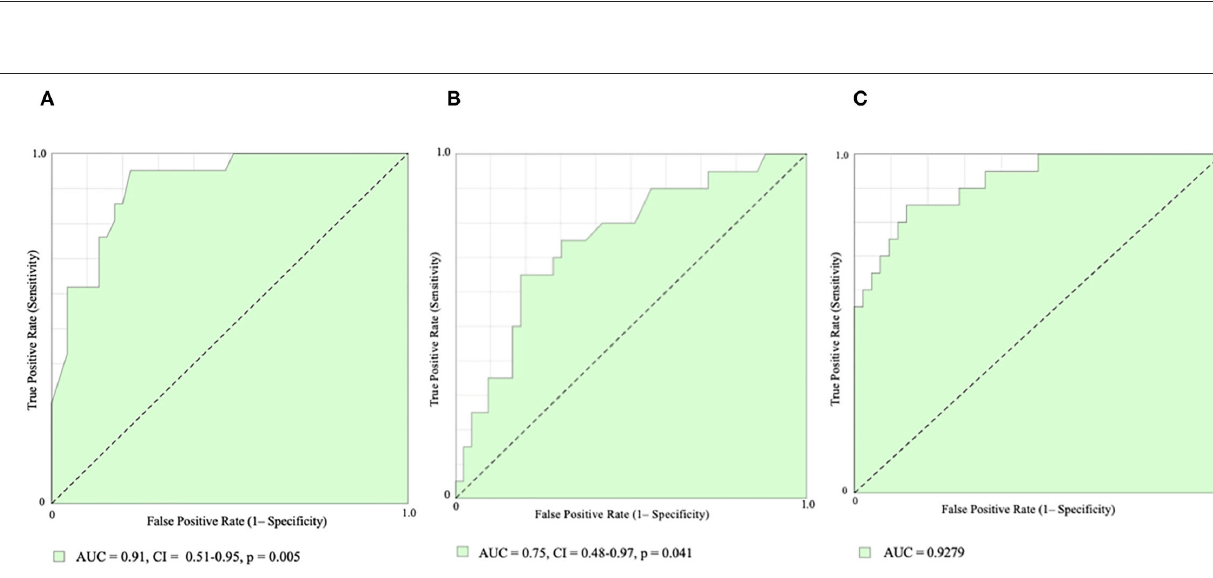
Frontiers in Cardiovascular Medicine | www.frontiersin.org